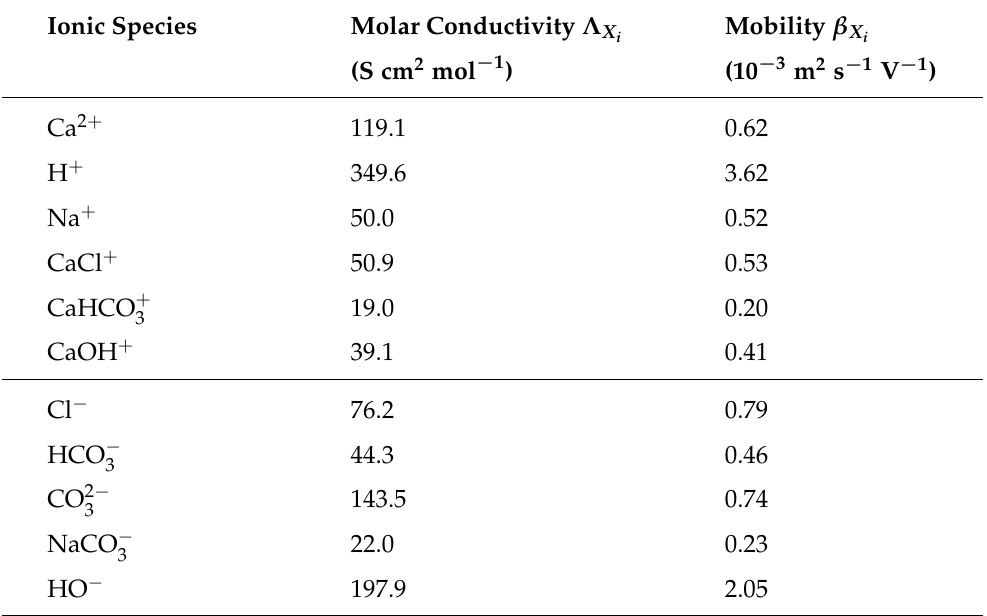
Table 2. Values of molar conductivity and mobility of the ionic species considered in this study. These values are taken from the literature